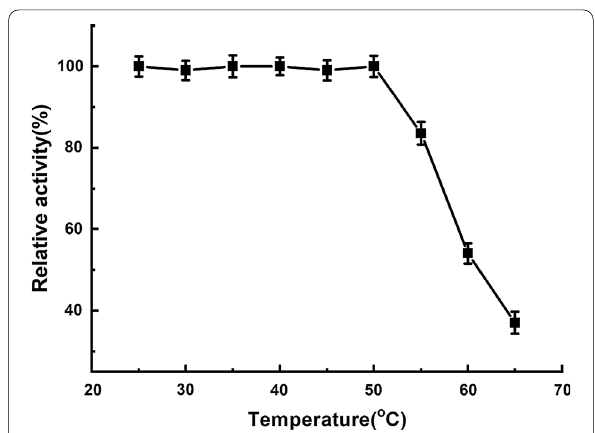
Fig. 6 Effect of temperature on the stability of esterase Tan410